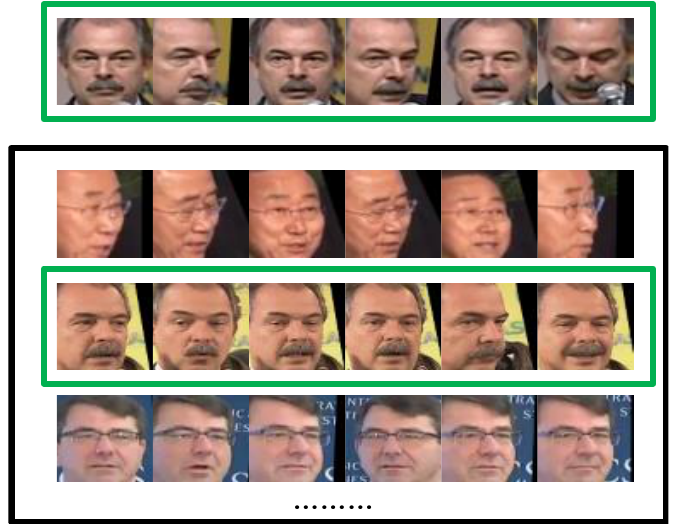
Figure 16. IJB-A identification (1:N) test protocol. Table 5. Accuracy of related algorithms in face recognition (1:N).